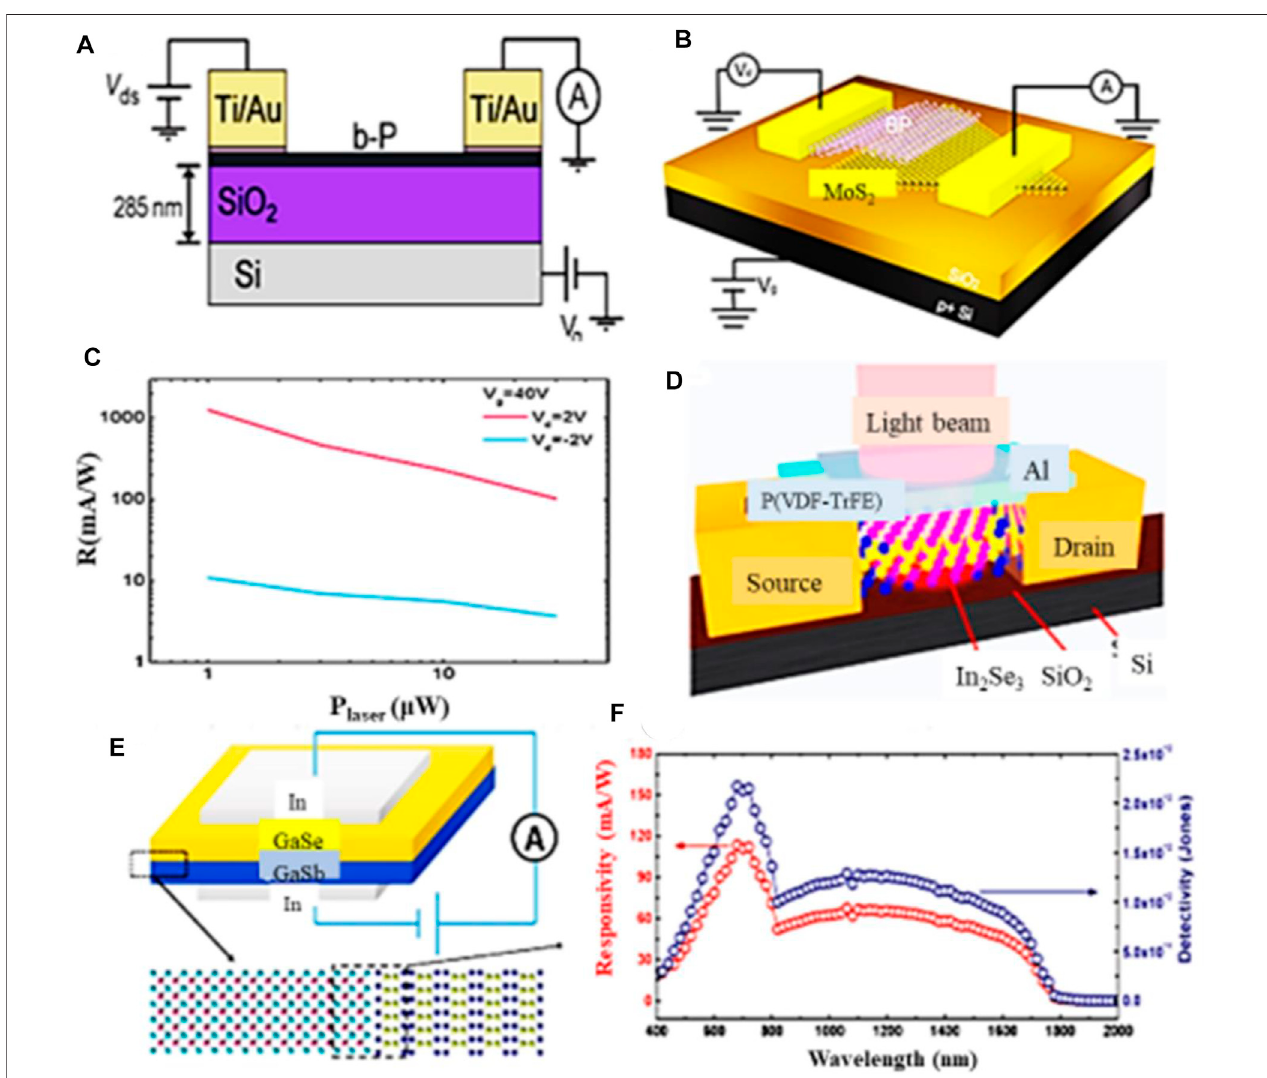
FIGURE16|(A) schematic ofBP based photodetector (Buscema etal., 2014), (B) schematic ofBP-MoS 2 basedphotodetector (Deng et al., 2014), (C) BP-MoS 2 based photodetector responsivity, (D) schematic of InSe based photodetector (Wu et al., 2016), (E) schematic of GaSe-GaSb based heterostructure photodetector (Wangetal.,2017),and (F) GaSe-GaSbbasedheterostructurephotodetectorresponsivity(Wangetal.,2017);Reproducedwithpermissionfrom(Buscemaetal.,2014; Deng et al., 2014; Wu et al., 2016; Wang et al.,